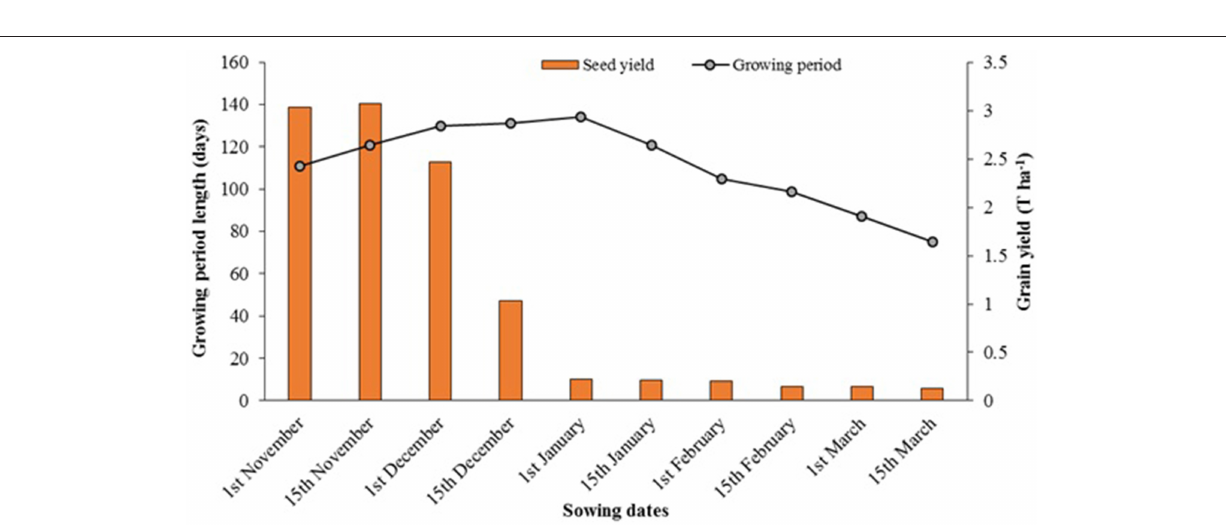
FIGURE 7 | Seed germination and seedling growth after 2 days- under different NaCl & Bontera solution Concentrations (Gill et al., 2016).